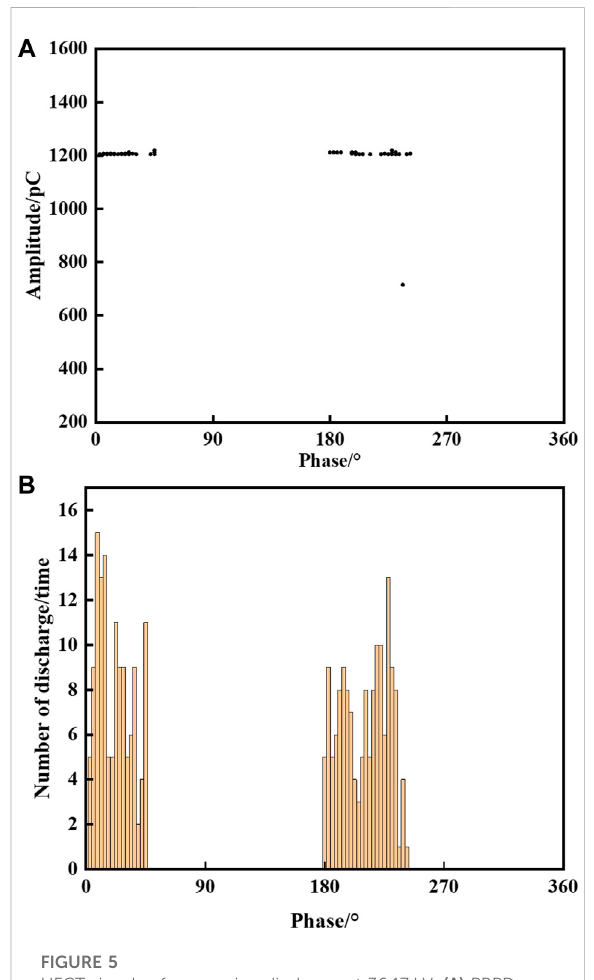
FIGURE 5 HFCT signals of suspension discharge at 36.17 kV. (A) PRPD pattern. (B) φ − n.